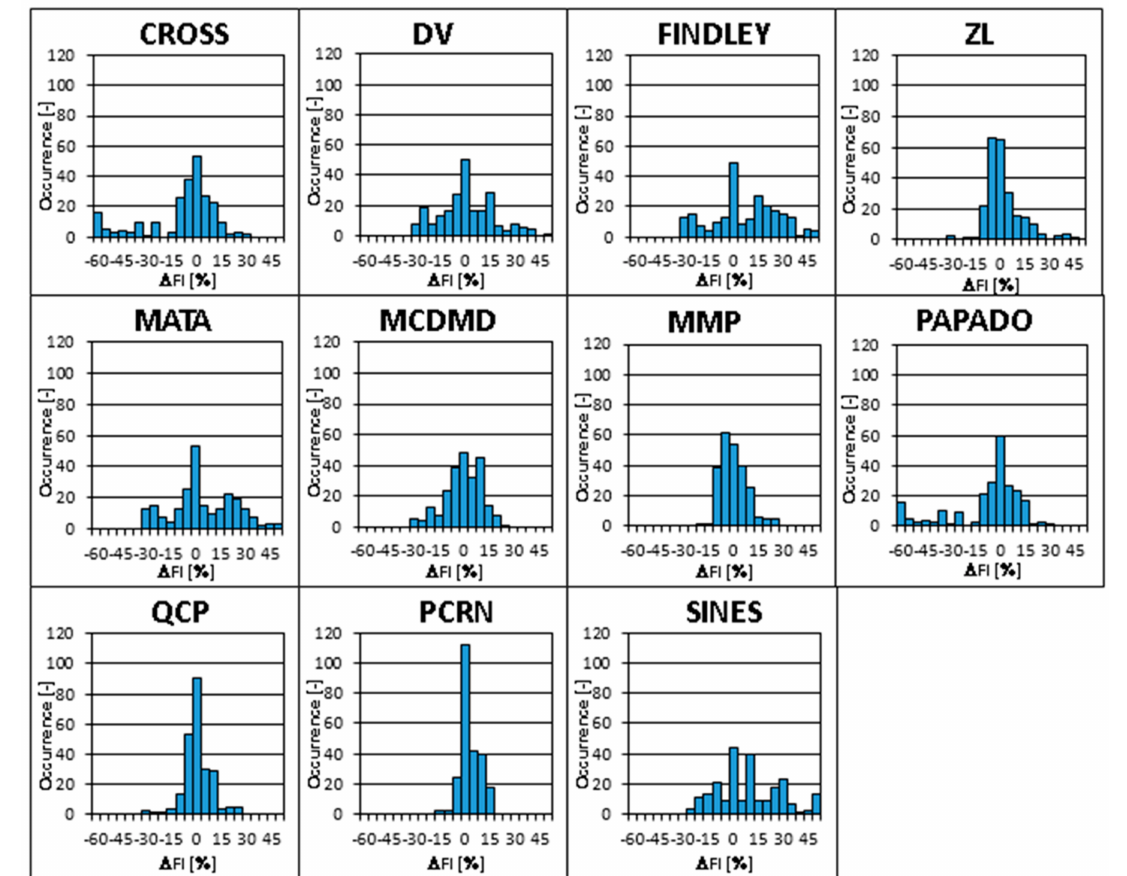
Figure 8. Histograms of ∆ FI errors for all 34 test cases, 7 evaluated lifetimes and all 11 multiaxial fatigue strength criteria validated according to Table